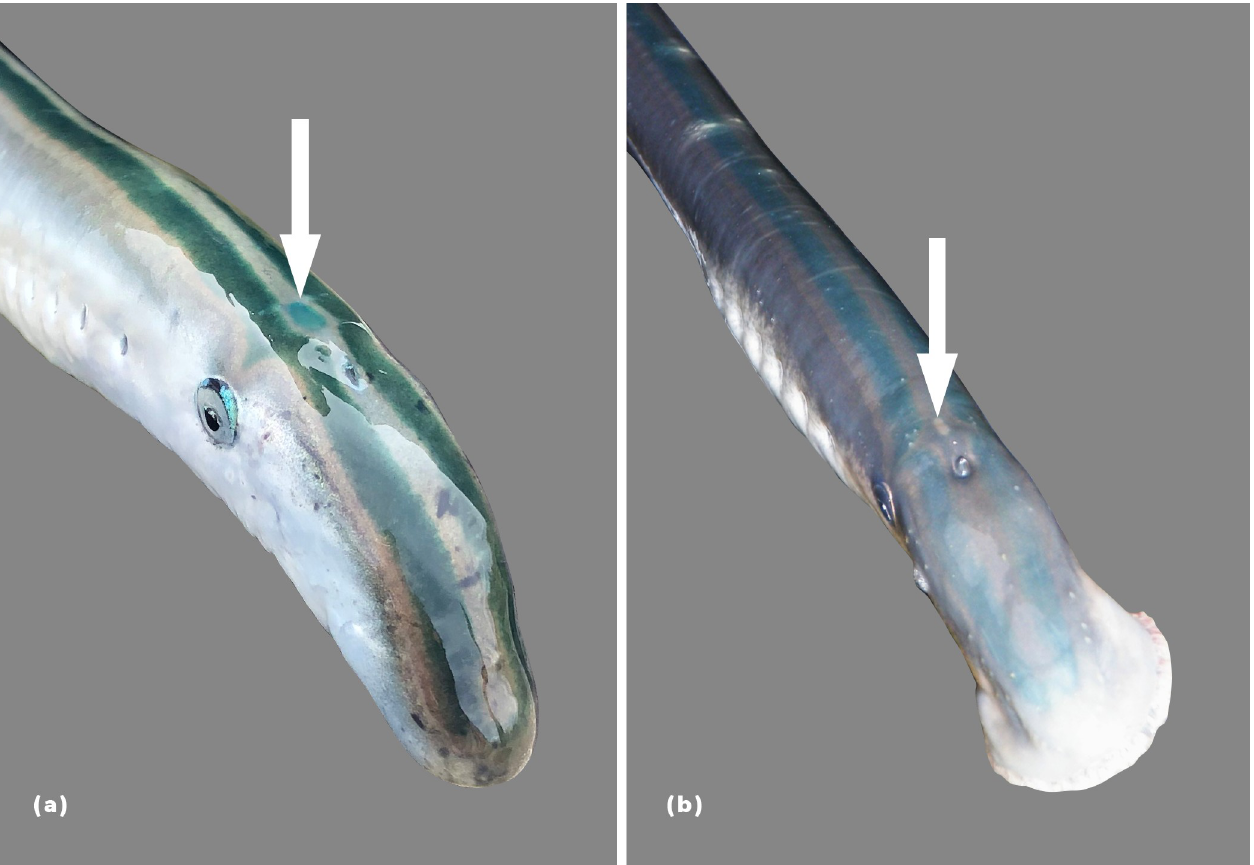
Fig 3. Coloration of fresh run Geotria lampreys. a) G . macrostoma displaying the iridescent blue markings on the outer edge of the eye and over the pineal gland (arrow) and the two blue-green longitudinal stripes characteristic of both Geotria species, b) G . australis lacking iridescent blue markings on the outer edge of the eye and over the pineal